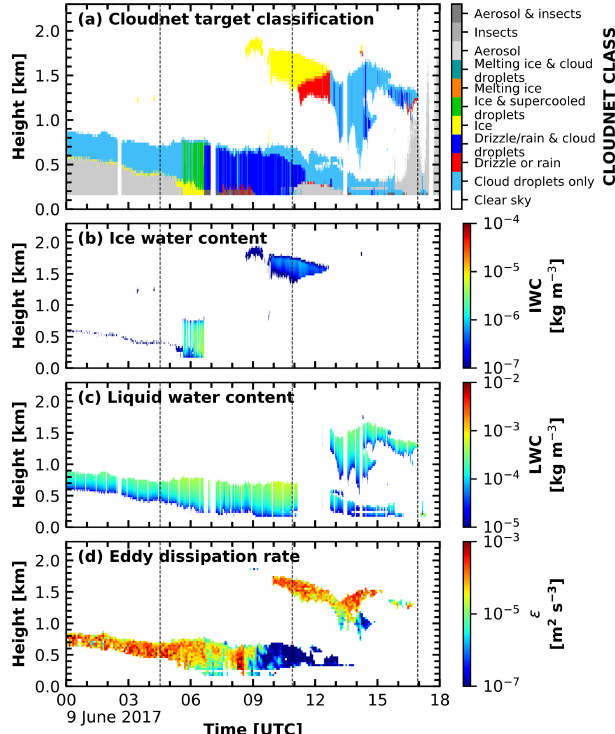
Figure 11. (a) Cloudnet target classification, (b) ice water content, and (c) liquid water content for 9 June 2017 between 00:00 and 18:00UTC. Panel (d) shows the time–height profile of EDR calcu- lated from the cloud radar Doppler velocity. The dashed lines mark the time of the radiosonde launches as shown in Fig. 9.